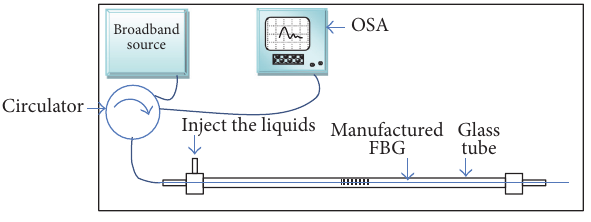
Figure 6: Reflection spectrum measurement by a D-shaped FBG with TiO 2